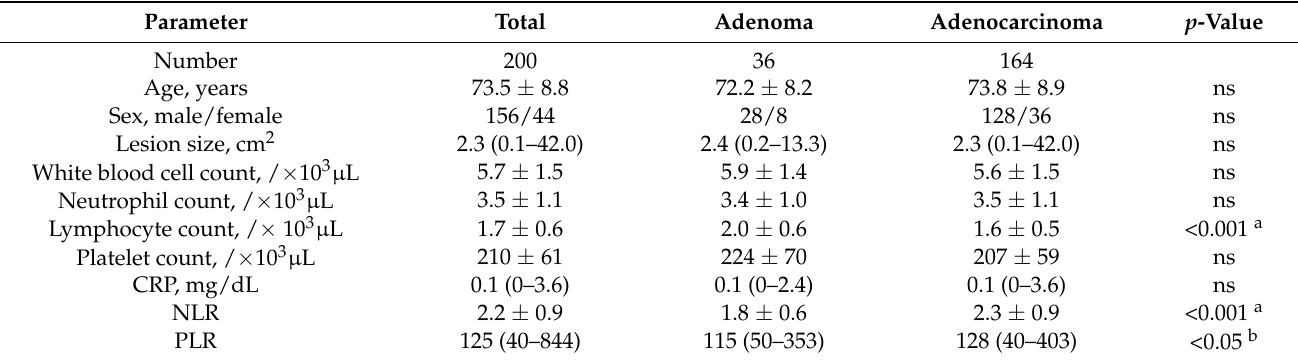
Figure 1. Study design. Among the 218 patients that were included in this study, 200 were analyzed and 18 were excluded. Table 1. Patients’